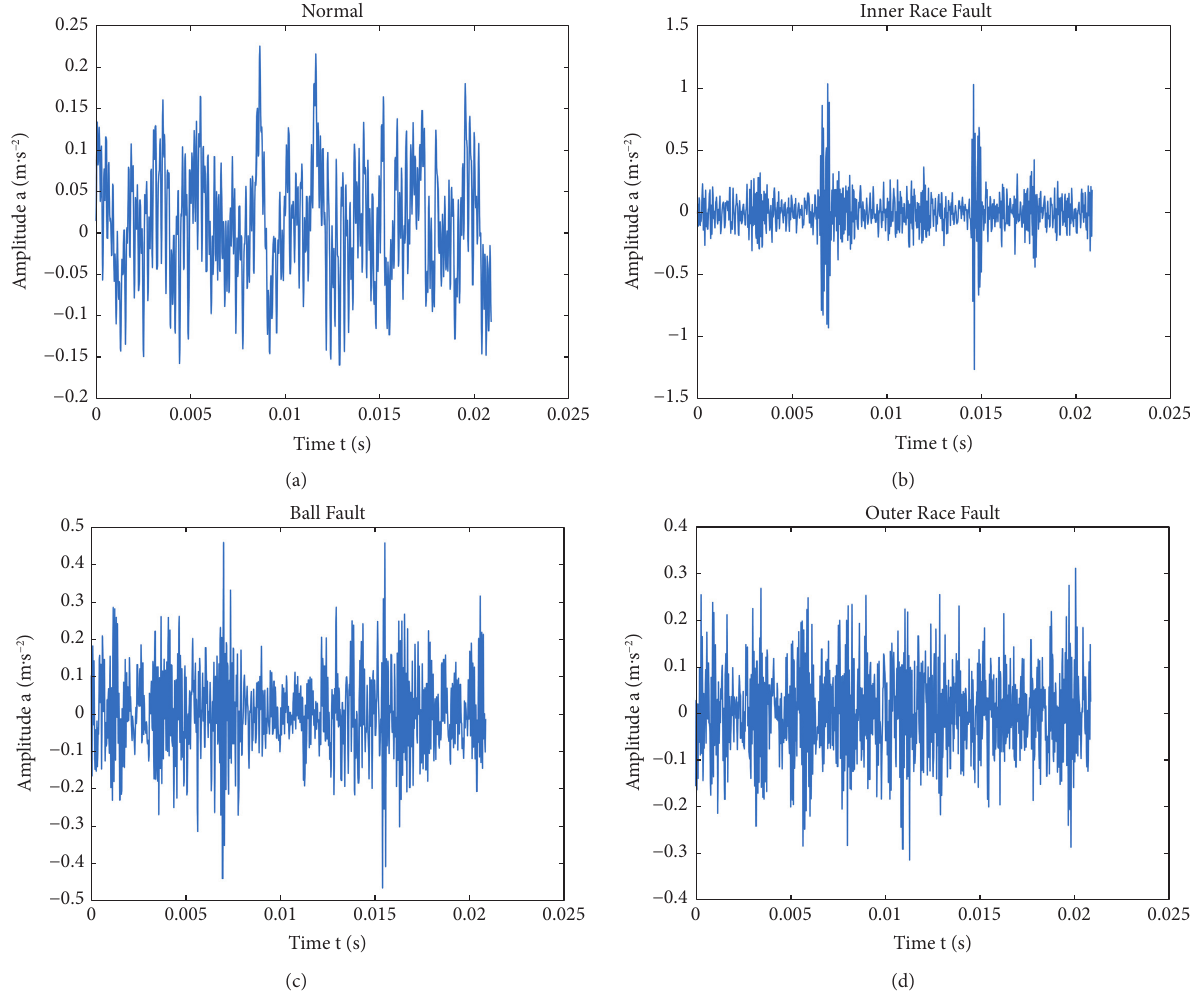
Figure 5: Time domain waveform of vibration signals in four bearing States. (a) Normal signal. (b) Inner race fault signal. (c) Ball fault signal. (d) Outer race fault signal.